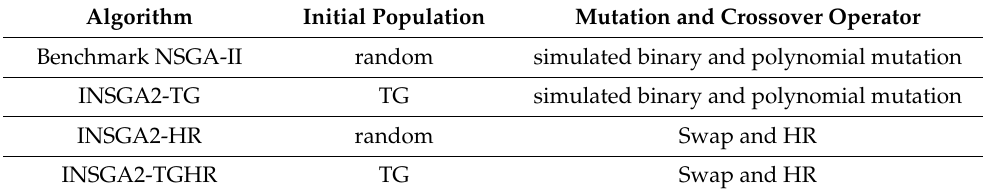
Table 4. Ablation of INSGA2-TGHR.